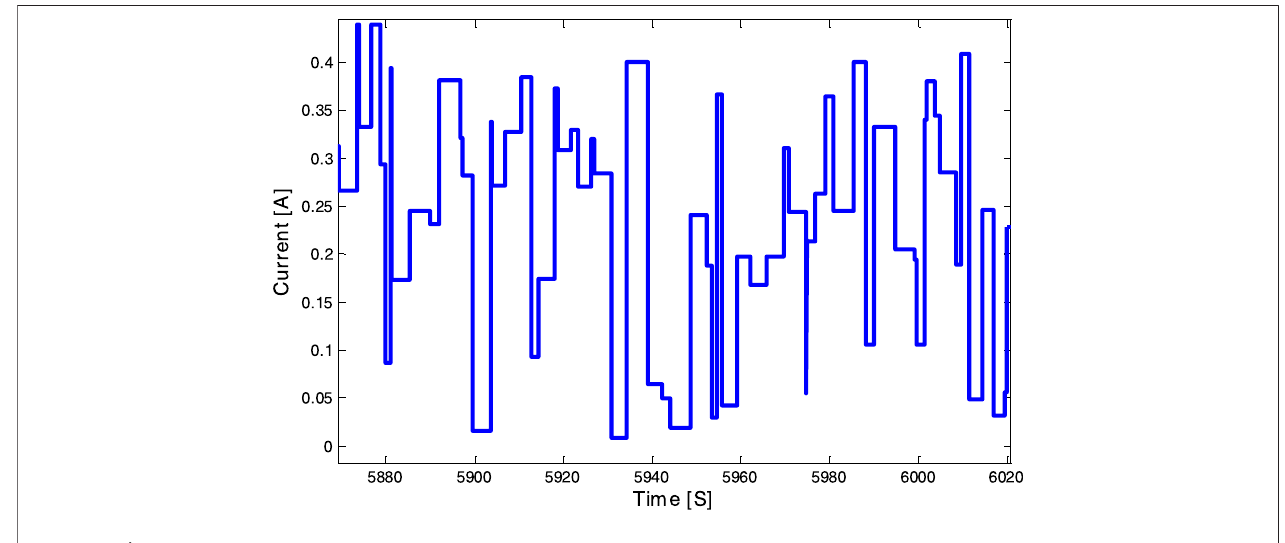
FIGURE 11 | Zoom-in of the random bias noise.